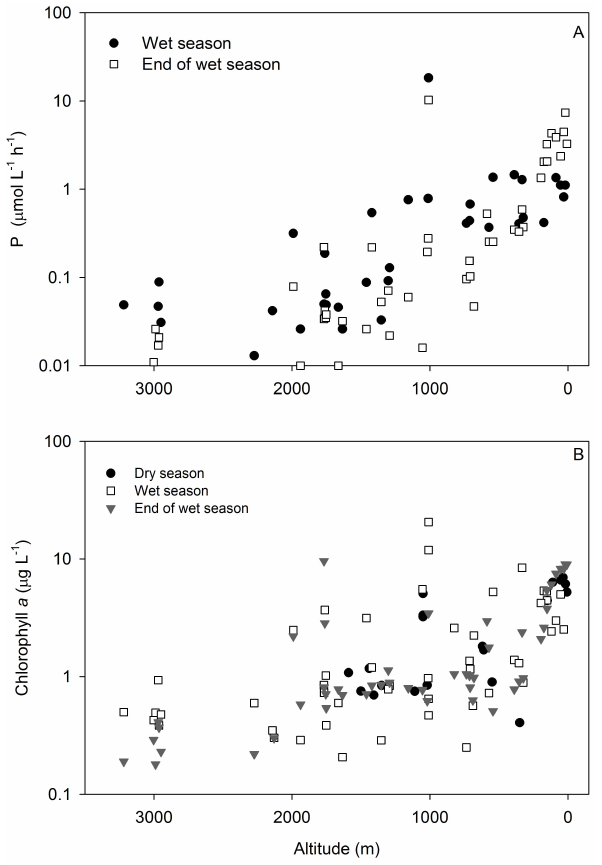
Fig. 9. Altitudinal profile of (A) primary production and (B) chloro- phyll a along the Tana River basin during different sampling sea- sons.